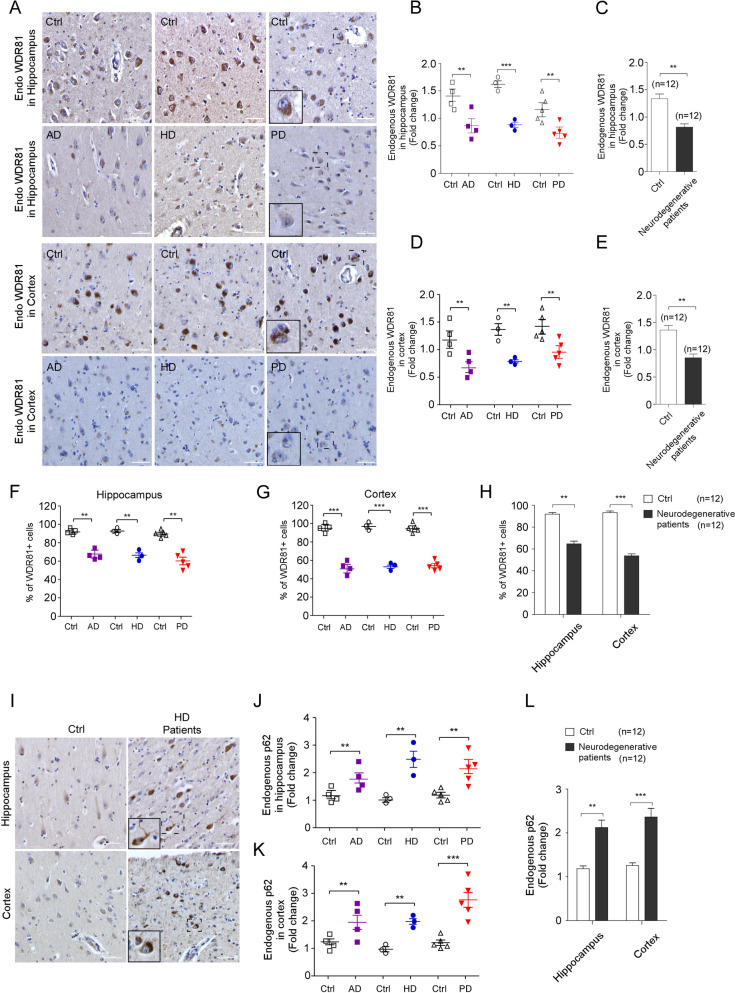
WDR81 is decreased in brains of patients with indicated neurodegenerative diseases compared with brains of control individuals.(A) Representative images of IHC staining of endogenous WDR81 proteins in hippocampus and cortex of brains from Ctrls and patients with AD, HD and PD. Boxed regions are magnified to show change of endogenous WDR81 in cytosol of cells. (B) Quantification of endogenous WDR81 in hippocampus of Ctrls and patients with indicated neurodegenerative diseases separately. 220 cells in 10 fields of each sample were measured. (C) Quantification of endogenous WDR81 in hippocampus of 12 Ctrls and 12 patients with indicated neurodegenerative diseases together. 220 cells in 10 fields of each sample were measured. (D) Quantification of endogenous WDR81 in cortex of frontal lobe from Ctrls and patients with indicated neurodegenerative diseases separately. 260 cells in 10 fields of each sample were measured. (E) Quantification of endogenous WDR81 in cortex of frontal lobe from 12 Ctrls and 12 patients with indicated neurodegenerative diseases together. 260 cells in 10 fields of each sample were measured. (F and G) Ratio of WDR81-positive cells in the sections of hippocampus and cortex of frontal lobe from Ctrls and indicated patients separately. 300 cells in 10 fields of each sample were measured. (H) Ratio of WDR81-positive cells in the sections of hippocampus and cortex of frontal lobe from 12 Ctrls and 12 indicated patients together. 300 cells in 10 fields of each sample were measured. (I) Representative images of IHC staining of endogenous p62 in hippocampus and cortex of brains from Ctrls and patients with HD. (J) Quantification of endogenous p62 in hippocampus of Ctrls and patients with indicated neurodegenerative diseases separately. 280 cells in 10 fields of each sample were measured. (K) Quantification of endogenous p62 in cortex of frontal lobe from Ctrls and patients with indicated neurodegenerative diseases separately. 280 cells in 10 fields of each sample were measured. (L) Quantification of endogenous p62 in the sections of hippocampus and cortex of frontal lobe from 12 Ctrls and 12 indicated patients together. 280 cells in 10 fields of each sample were measured. Scale bars represent 50 μm in all panels. Brain samples from 12 Ctrls and 12 patients with indicated neurodegenerative diseases (AD, n = 4; HD, n = 3; PD, n = 5) were obtained from the Chinese Brain Bank of Zhejiang University (S1 Table). For quantifications, data were calculated by software Image J and analyzed using ANOVA or t-test (Prism). ** P <0.01, *** P <0.001.